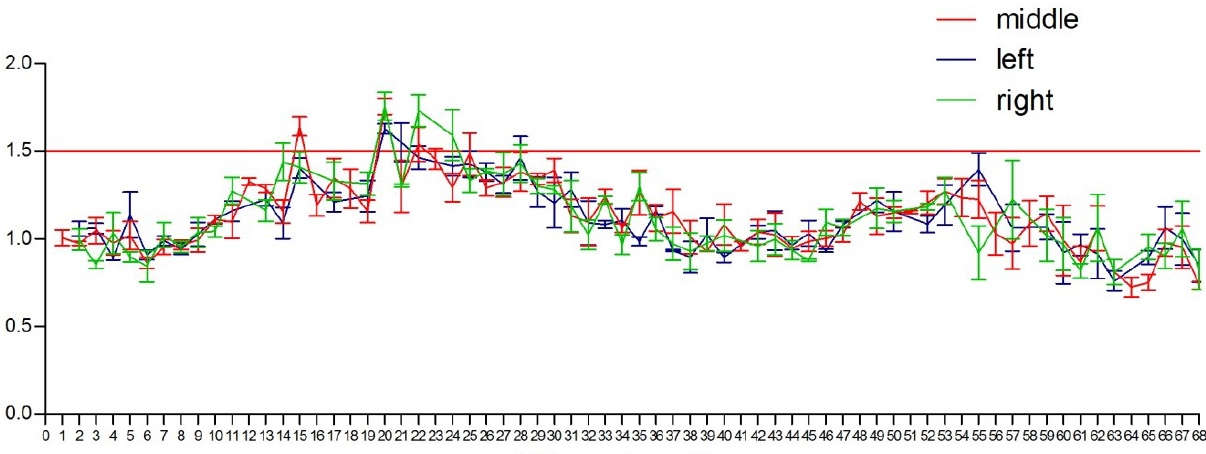
Figure 3. Results from umuC testing of the river Danube with enzymatic activation. The red line at 1.5 represents the limit value. Values at JDS15 M, JDS20 L,M,R, JDS21 L, and JDS22 R, clearly override the limit value. Values are also increased before and after JDS55 but do not exceed the limiting value. Growth of Salmonella is impaired beginning at JDS60 but does not fall below 75% compared to the growth